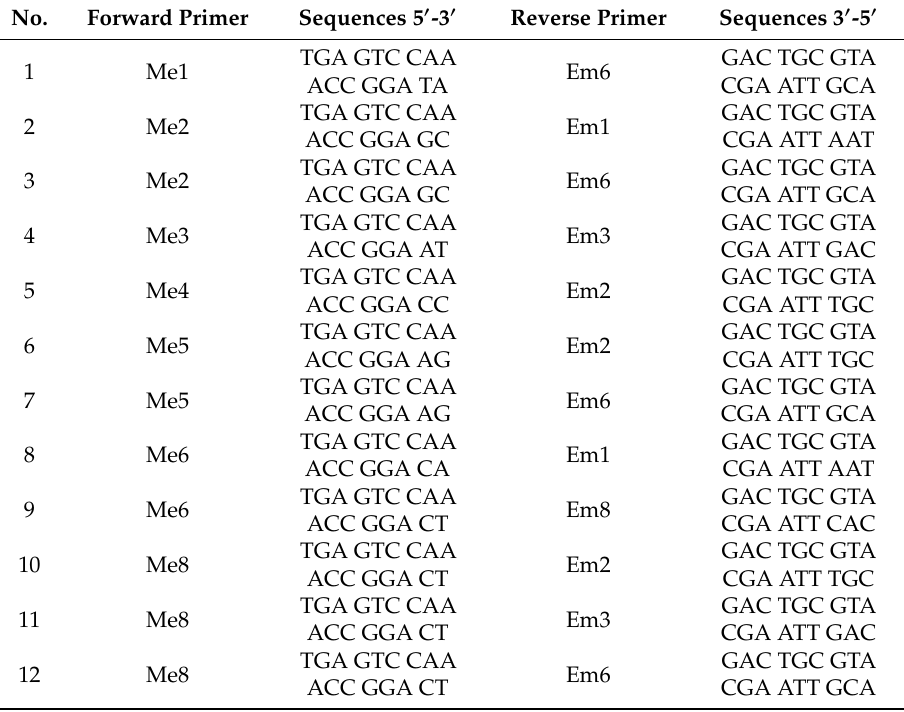
Table 5. SRAP primer combinations used in this